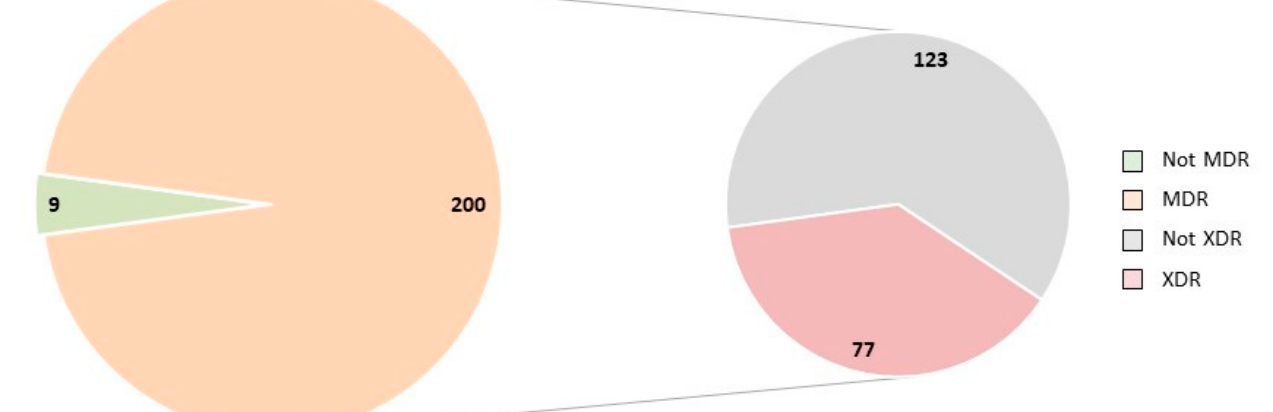
Figure 1. Categorization of the 209 E. coli isolates investigated based on their antimicrobial resistance profiles into multidrug resistant (MDR) and non-MDR, and their further subdivision into extensively drug-resistant (XDR) and non-XDR Not MDR—isolates without multidrug resistance; MDR—isolates with multidrug resistance; not XDR—isolates without extensive drug resistance; XDR—isolates with extensive drug